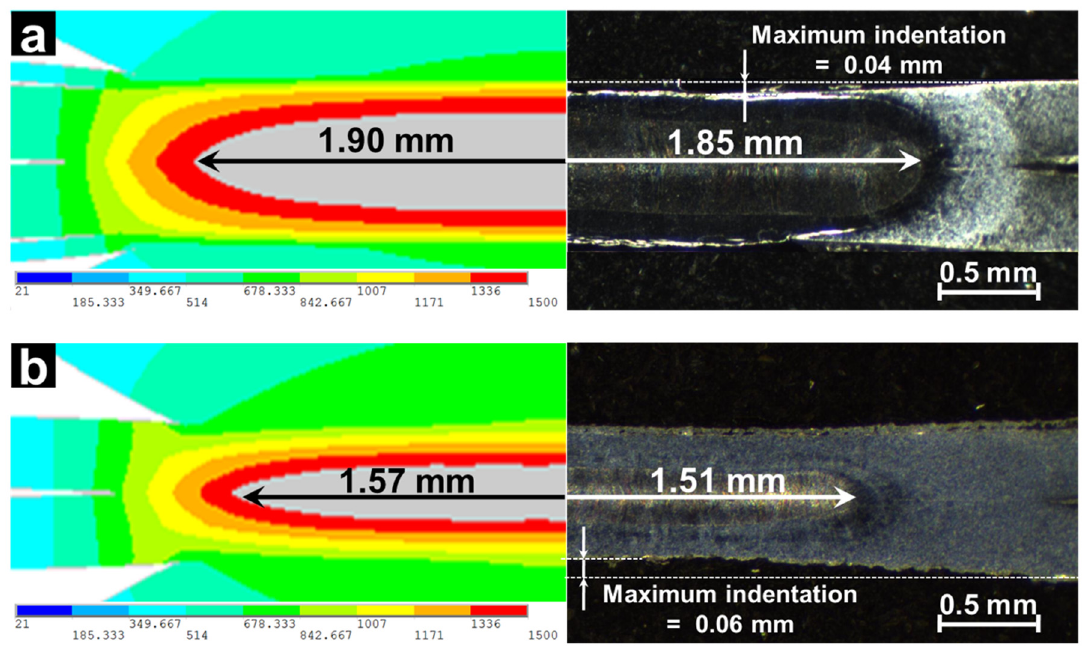
Figure 6. Comparison of calculated result and experimental result, ( a ) with a 0.10 mm AISI304 steel strip and ( b ) without strip [4]. Reprinted with permission.